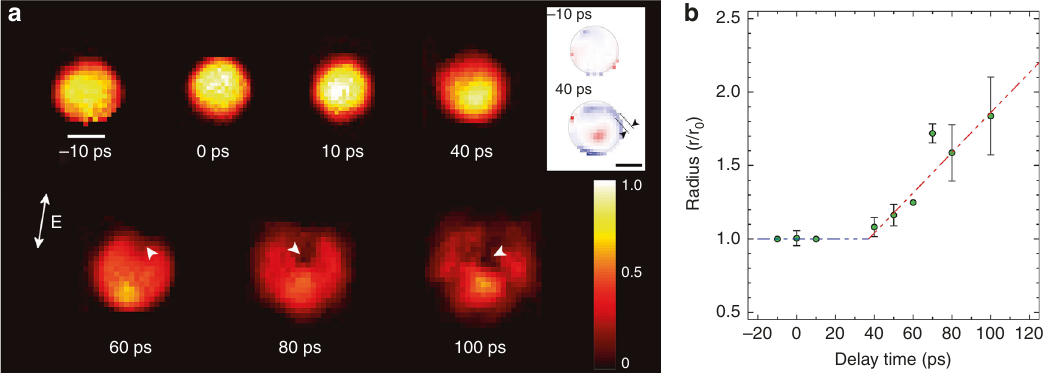
Fig. 3 Time resolved single-shot images of single Au nanospheres during melting. a Single-shot images visualize the melting processes in single Au nanospheres through the projected density ( a ). White arrowheads in 60 – 100 ps in a track the void formation. The variation of the projected density for 40 ps near the surface is emphasized by displaying the density difference from ideal sphere, which visualizes inhomogeneous melting at the surface with layer thickness of ~10 nm marked with two arrowheads in (inset). The scale bar shows 50 nm and the polarization direction of the pumping laser is shown with the arrow in a . The scale bar for the colormap shows scaled projected density to have one as the maximum value of the original intact sphere. b The temporal evolution of the size of the Au nanosphere on the melting is obtained. More rapid expansion of the particle size during the melting transition is noted from ~ 40 ps as from with the temporal evolution of sample radius in b . Error bars indicate the standard deviations. Lines are guides to the eyes and its slope is ~700 m s